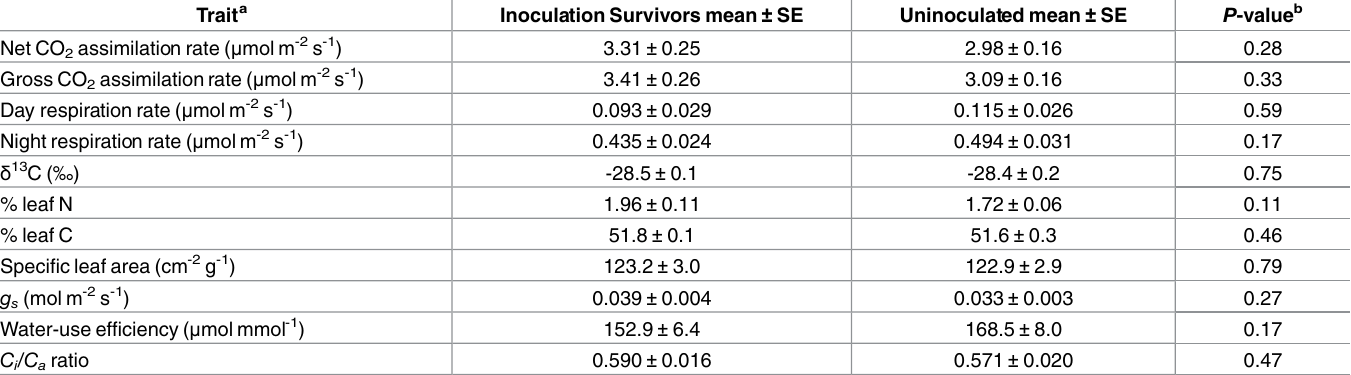
Table 4. Meanleaf-levelgas exchangeand resource investmentparameters for InoculationSurvivorand Uninoculated populationsof limberpine ( ± SE). Trait a Inoculation Survivors mean ±